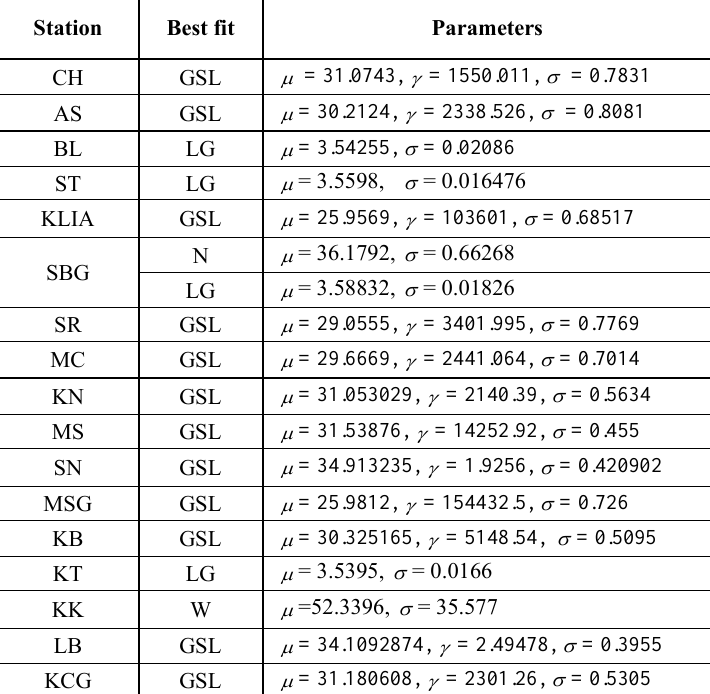
Table 4. The best fitted probability distribution for seventeen meteorological stations in Malaysia.